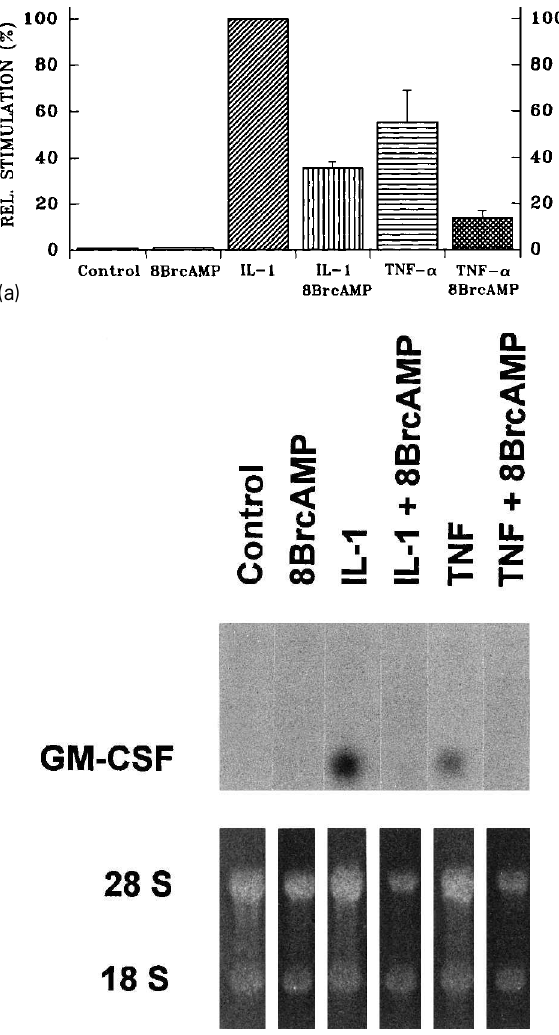
FIG. 2. Effect of 8BrcAMP on the expression of GM-CSF by human stromal cells. Confluent secondary stromal cultures were incubated in medium alone or with the addition of IL-1 (100U/ml), TNF- a (500U/ml), 8BrcAMP (0.5mM) or combina- tions as indicated. (A) After incubation for 24h, GM-CSF concentrations in the supernatants were assessed using a specific ELISA. GM-CSF levels are presented as deviation from maximal stimulation. Single experiments were carried out in triplicate, and data from three independent experi- ments are summarized as mean ± SEM. (B). After incubation for 6h, total cellular RNA was prepared and subjected to Northern-blot analysis with cDNA probe for human GM-CSF. The 18 and 28S rRNA from ethidium bromide stained gel is shown as loading control. Data are representative for three experiments with stromal cells from different